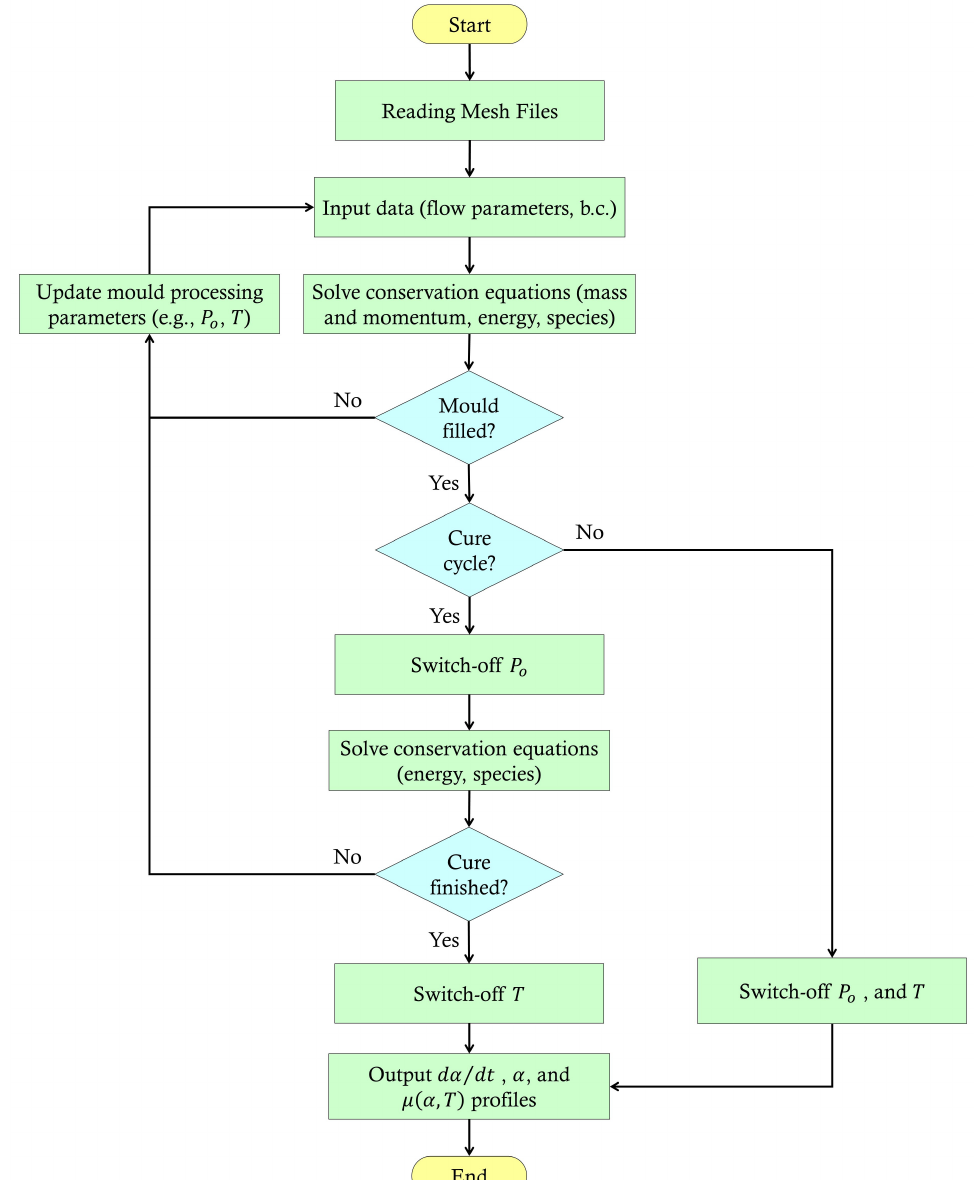
Figure 2. Flowchart that illustrates the proposed numerical approach for filling and curing the simulation of an LCM process